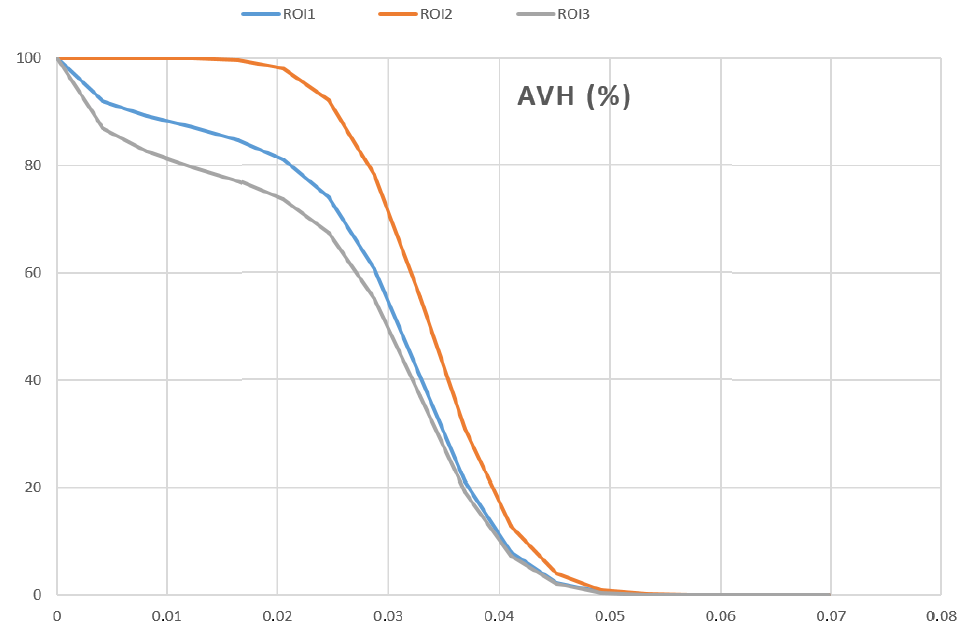
Figure 8. AVHs of three ROIs delineated on cylindrical homogenous phantom are reported. ROI1 = delineation performed considering the physical volume of the phantom. ROI2 = delineation performed considering 80% of the inner volume of the cylinder. ROI3 = delineation performed with the Whole Body Tool to include phantom wall and cap.